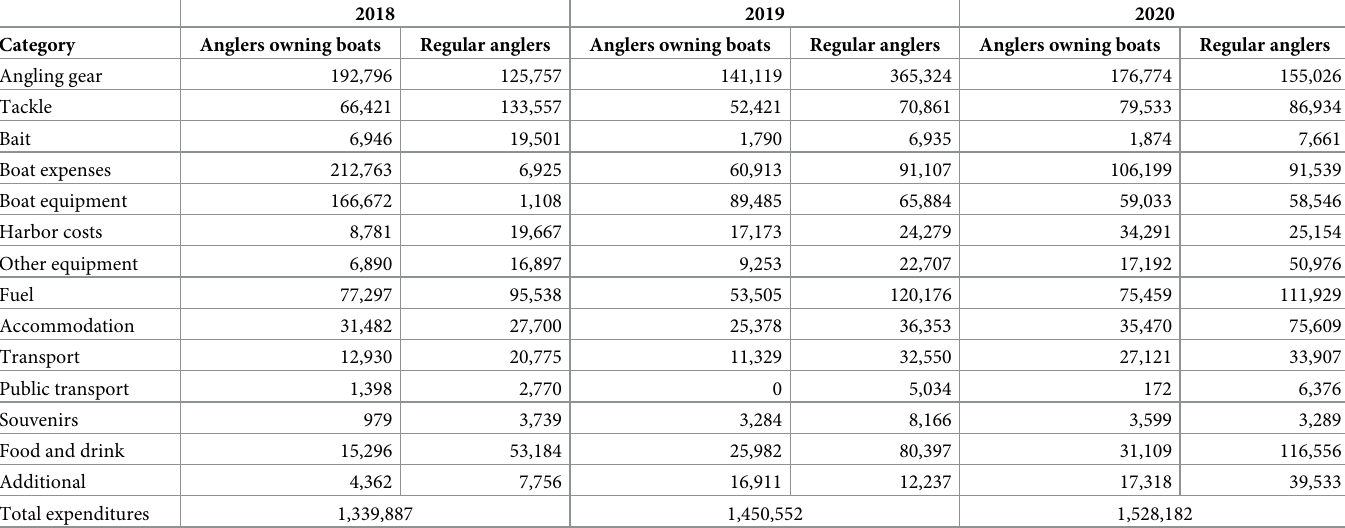
Table 3. Total annual expenditures in EUR by category for regular anglers and anglers owning boats exclusively related to recreational fishing for ABFT as part of the T&R